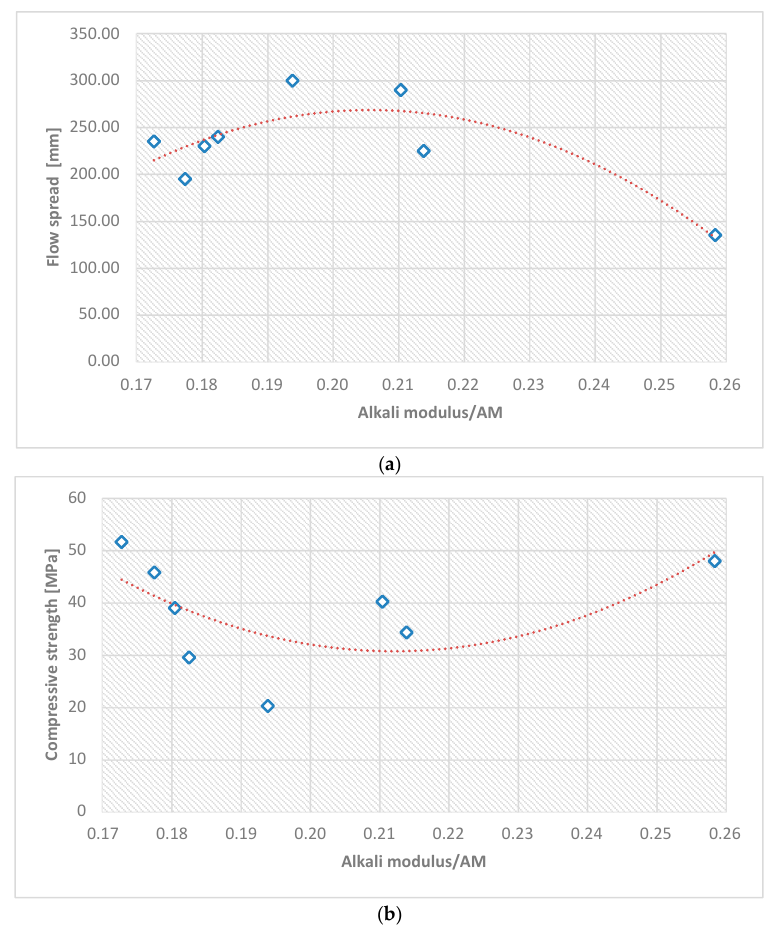
Figure 7. Effect of alkali-modulus (AM) on technical performance of the developed mortars: ( a ) flow spread and ( b ) compressive strength trend.